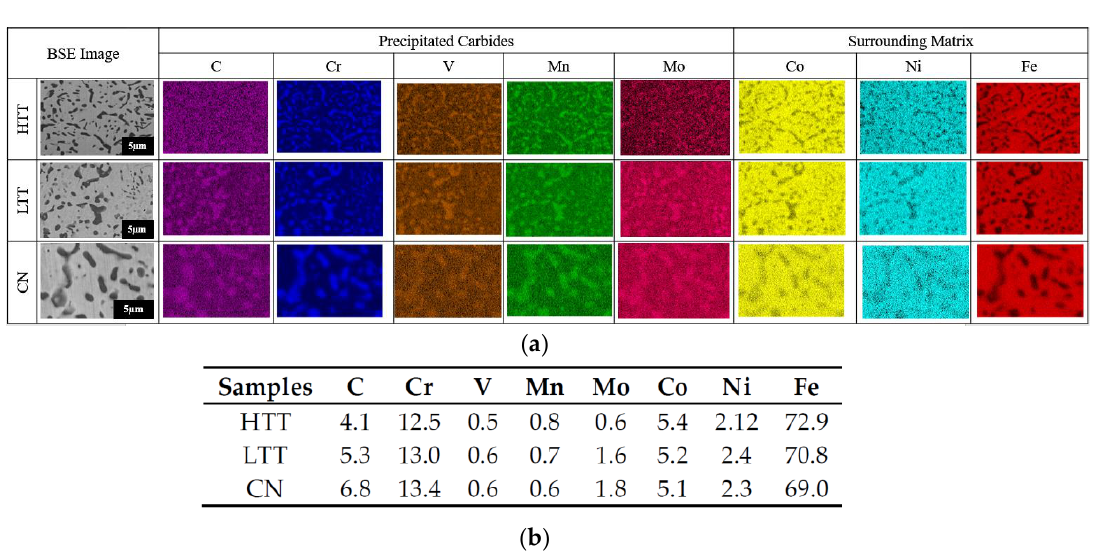
Figure 2. ( a ) Grayscale backscattered electron (BSE) images (left column) of the three different P675 surface-treated samples (carbides appear darker than surrounding matrix) with corresponding colored energy-dispersive X-ray spectrometer (EDS) compositional maps highlighting the principal components of the carbides (middle columns) and bulk matrix (right columns) for the HTT, low-temperature tempered (LTT), and carbo-nitrided (CN) samples (images for each row share the same micron bar). ( b ) Elemental composition in wt.% (determined via EDS) for the surface of each steel (not individual carbides).